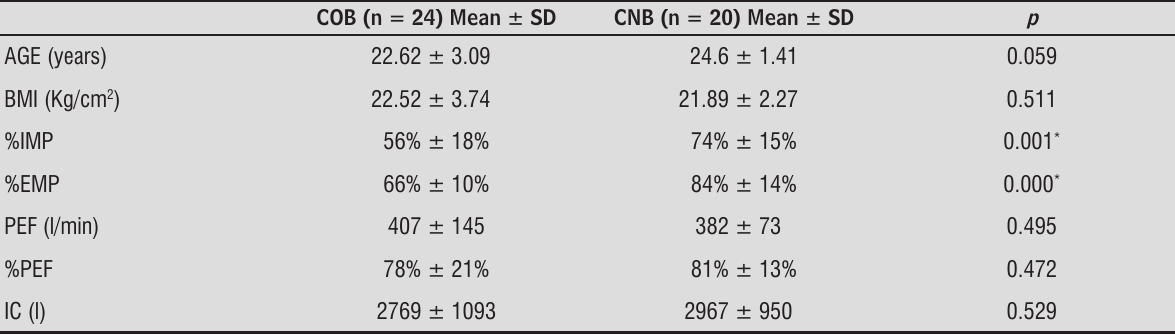
Table 1 - Comparison of demographic and respiratory parameters between